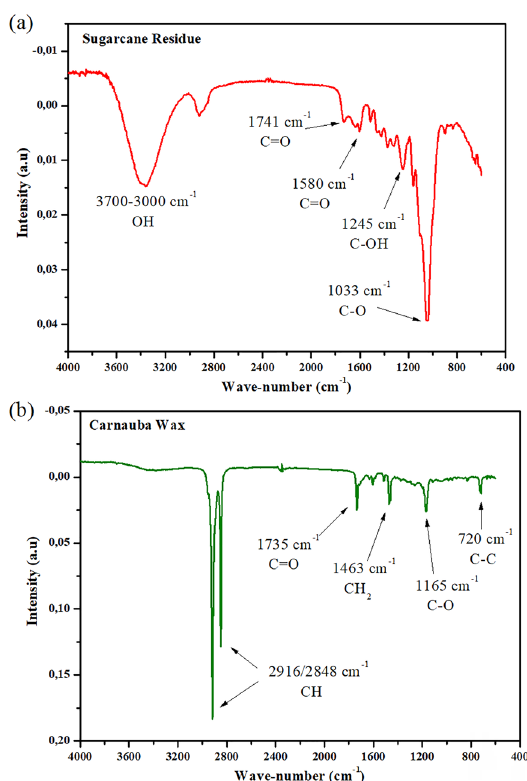
Figure 1. FTIR spectra in the range of 4000-400 cm -1 for (a) sugarcane residue and (b) carnauba wax. (colored in the online version)